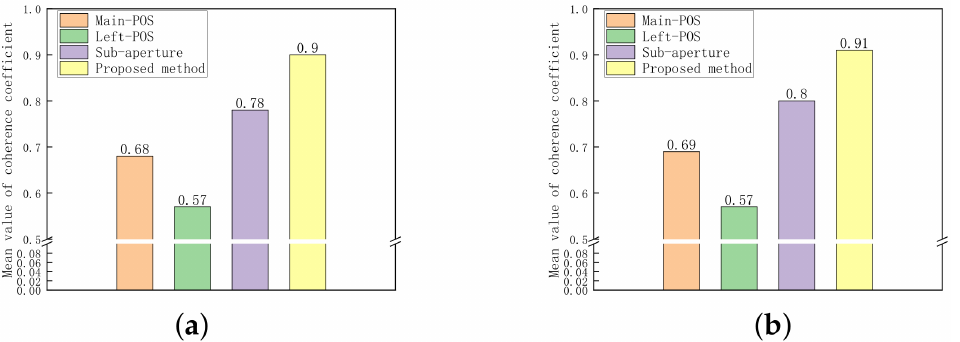
Figure 21. The mean values of coherence coefficient. ( a ) channel 1 and channel 3; ( b ) channel 1 and channel